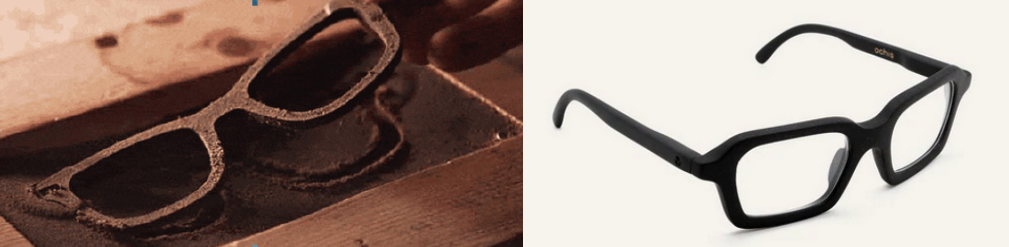
Figure 8. Coffee glasses “Ochis” from spent coffee grounds ( Open source photo ) [50].